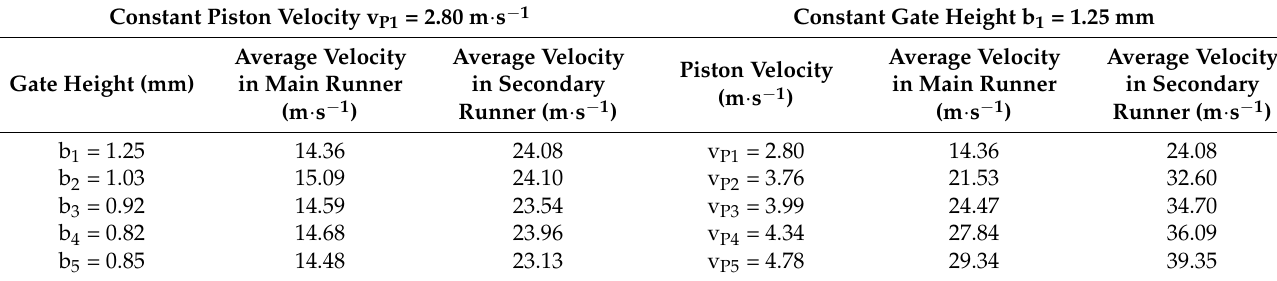
Table 4. Melt velocity in the